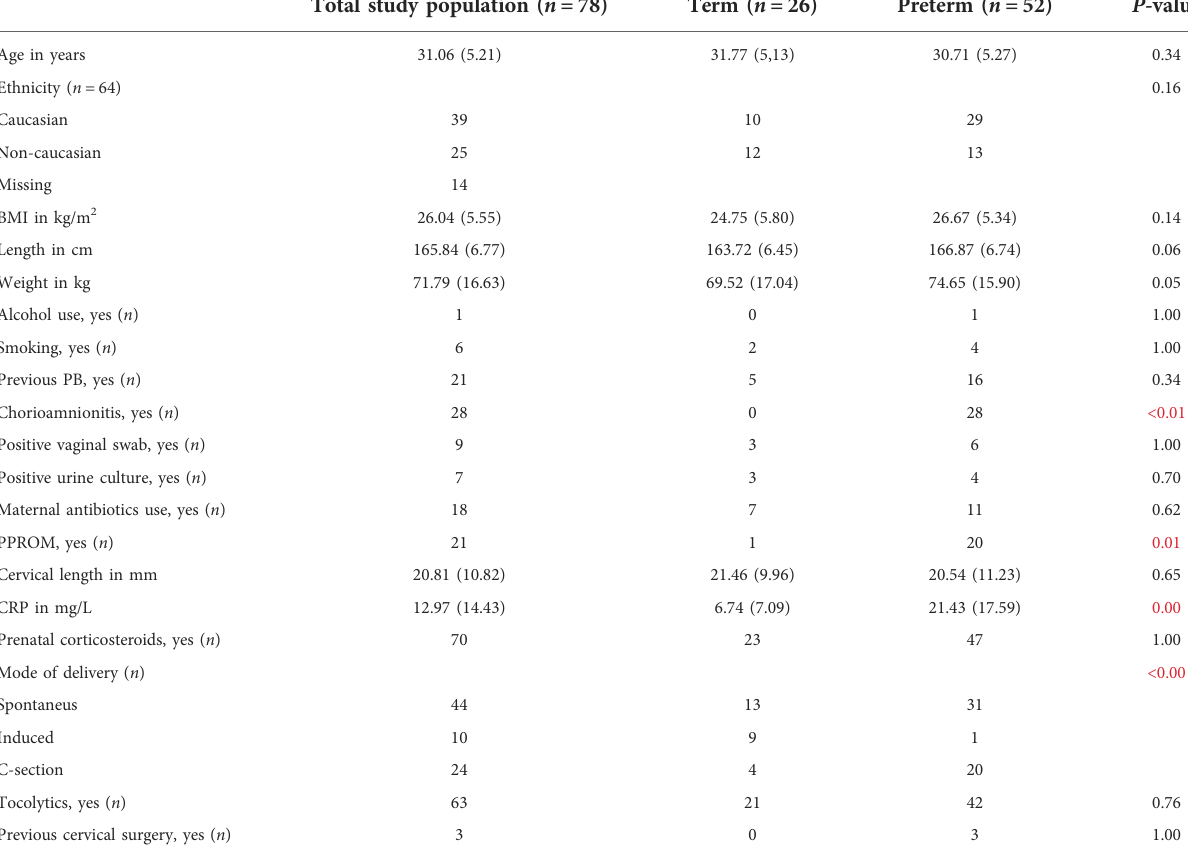
TABLE 1 Baseline characteristics of the whole study population ( n =78). Data are presented as median with standard deviations (SD) and signi fi cant results are presented in